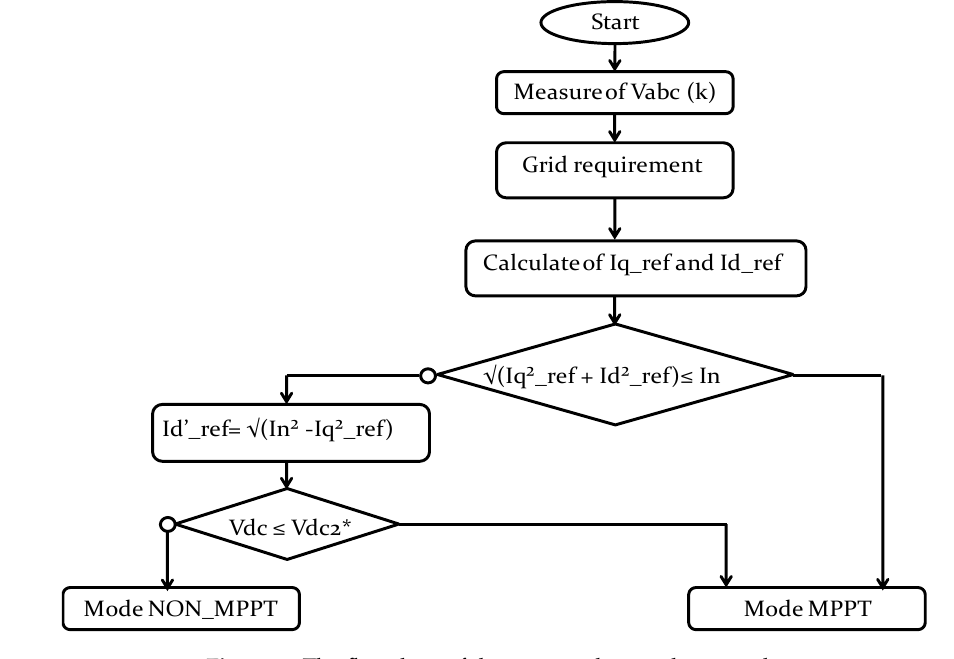
Figure 7. The flowchart of the proposed control approach.